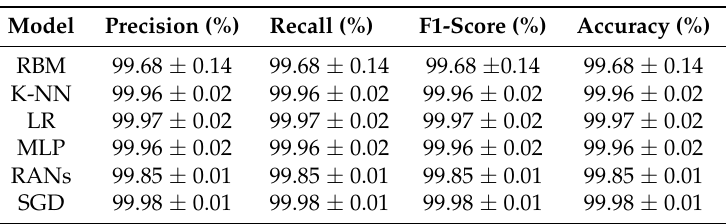
Table 5. RAN’s Comparative Study for UCIHAR